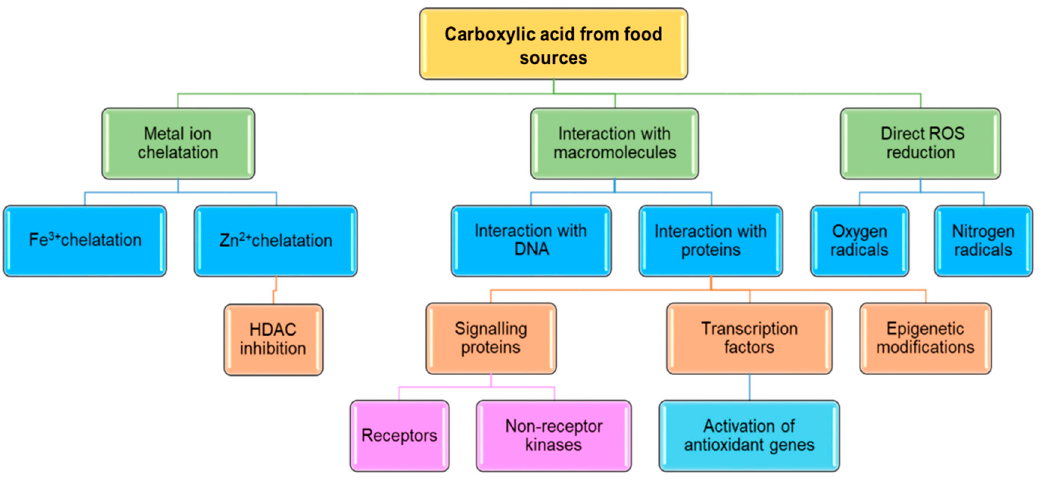
Figure 3. Selected molecular mechanisms of action of carboxylic acids from food sources. (HDAC—histone deacetylase).